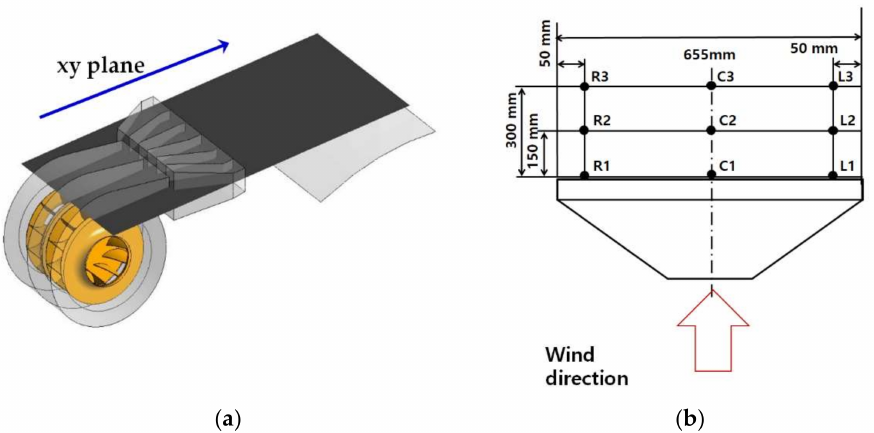
Figure 8. The xy plane on 3D model ( a ) and measuring position of blower on top view ( b